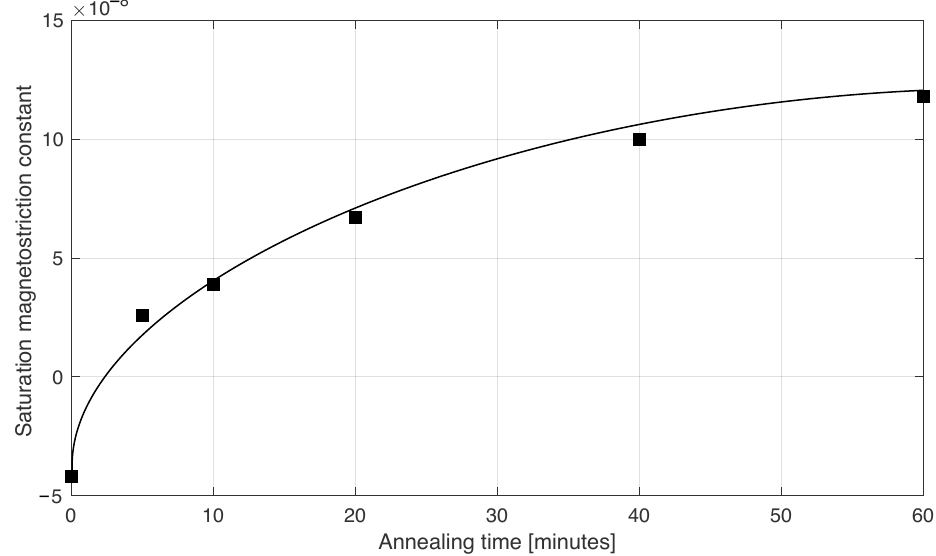
Figure 4. Saturation magnetostriction constant λ S of an Unitika wire with ( Co 0.94 Fe 0.06 ) 72.5 Si 12.5 B 15 composition vs. annealing